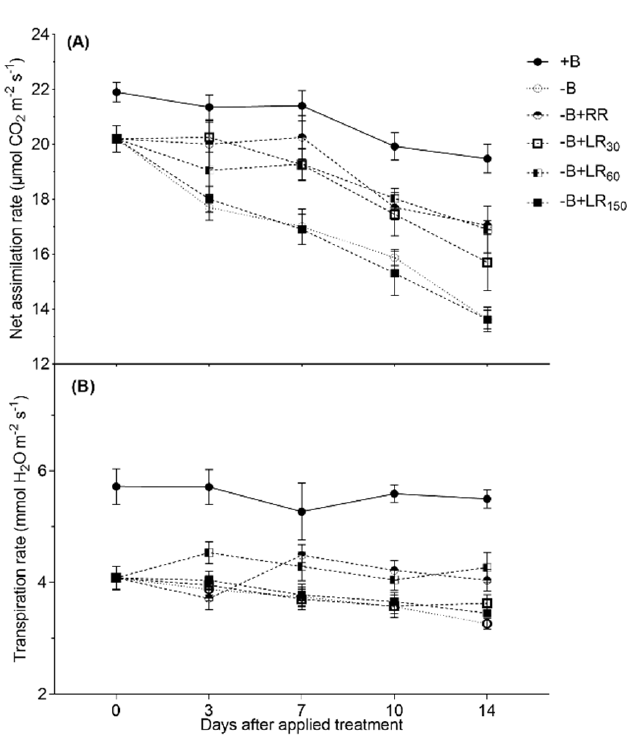
Figure 4. Changes in net CO 2 assimilation rate ( A ; µ mol CO 2 m − 2 s − 1 ) and transpiration rate ( B ; µ mol H 2 O m − 2 s − 1 ) of Brassica napus grown in nutrient solution under different B treatments for 42 days. +B, 25 µ M B in NS; − B, 0.25 µ M B in NS; − B+RR, 0.25 µ M B in NS for the first two weeks and then 25 µ M B for the latter two weeks; − B+LR 30 , 0.25 µ M B in NS and foliar-applied 30 mM B at two weeks; − B+LR 60 , 0.25 µ M B in NS and foliar-applied 60 mM B at two weeks; − B+LR 150 , 0.25 µ M B in NS and foliar-applied 150 mM B at two weeks. The data ± SE are means of four independent pot replicates. Different letters on bars indicate significant differences between treatments (ANOVA with Duncan’s multiple range test p ≤ 0.05).